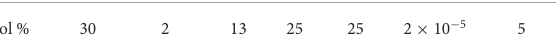
TABLE 2 Shale composition used in this study. Shale Calcite Gypsum Pyrite Illite Quartz Bitumen Porosity comp.